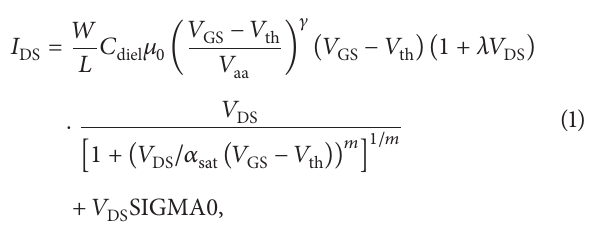
Figure 1: Illustrations of OTFT layout, fullerene, and pentacene molecular semiconductors and circuit symbols of fullerene N or pentacene P-channel OTFTs.